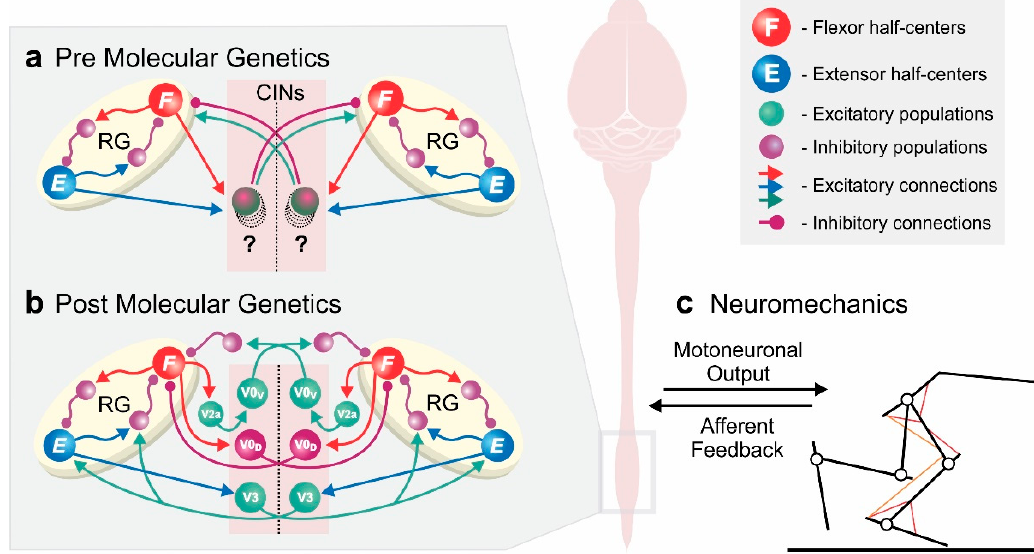
Figure 1. Conceptual overview of computational models of spinal locomotor circuitry. ( a , b ) Model schematics of two rhythm generators coupled by commissural interneurons (CINs), controlling and coordinating left and right rhythmic activities—based on classical experimental studies ( a ) and incorporating molecular genetic data ( b ). Experimental data of genetically modified animals allowed for models to disentangle the network of commissural interneurons coupling the rhythm generators on each side of the spinal cord. ( c ) Integrated models of neuronal locomotor circuits with the musculoskeletal system are needed to simulate molecular genetic manipulations in in vivo experiments and mechanistically relate them to behavioral changes. Schematic in ( b ) has been adapted from Danner et al. [10].